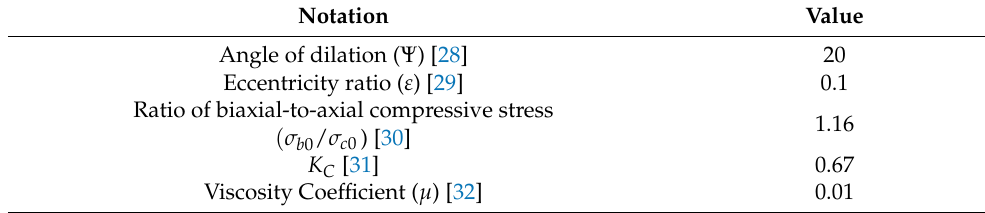
Table 3. Details of plasticity parameters.